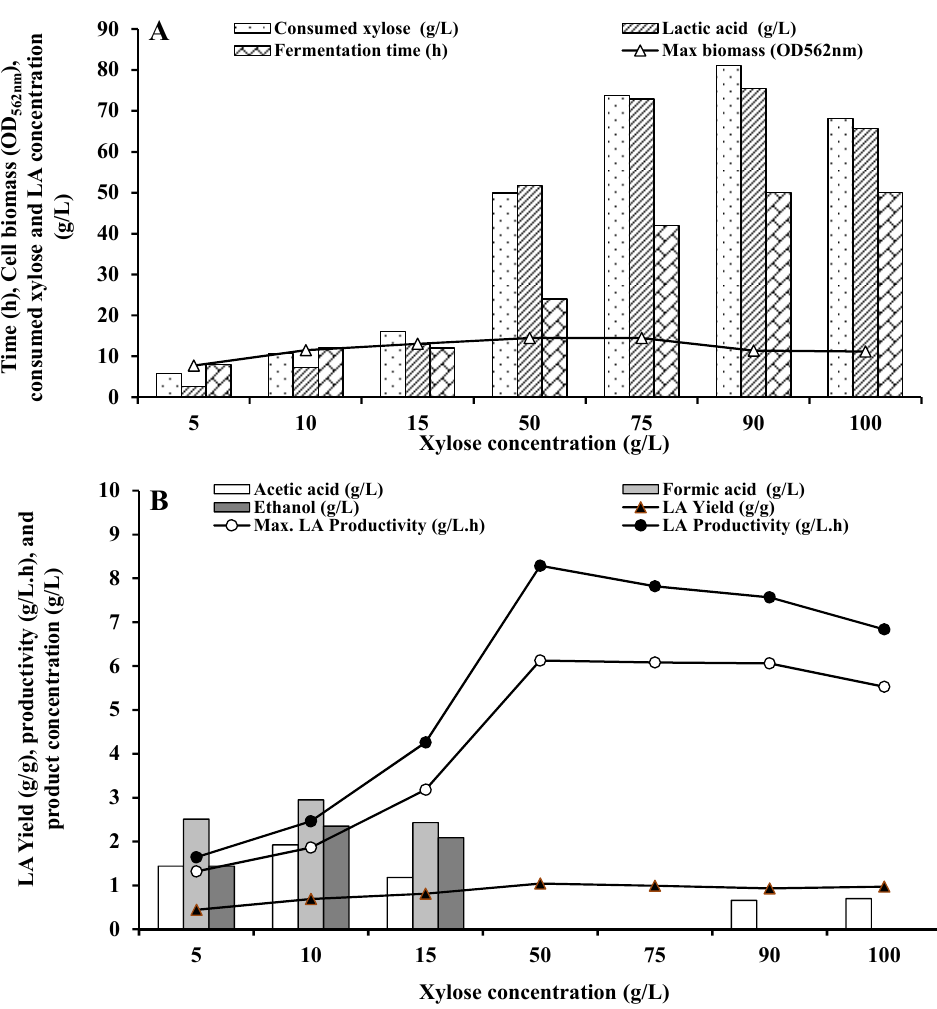
Figure 1. Profiles batch fermentation for lactic acid from different xylose concentrations by E. faecium s6 at controlled pH 6.5 and 45 °C.